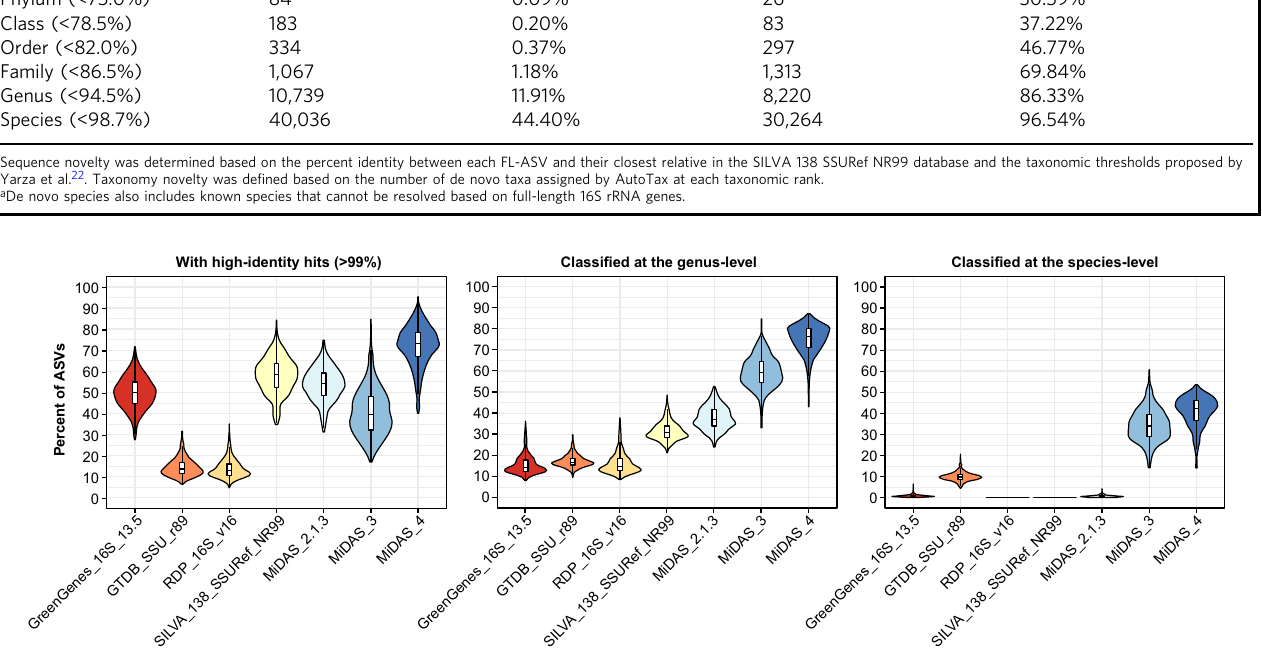
Fig. 3 Database evaluation based on amplicon data from the Global Water Microbiome Consortium project. Raw amplicon data from the Global Water Microbiome Consortium project 2 was processed to resolve ASVs of the 16S rRNA gene V4 region. The ASVs for each of the samples were fi ltered based on their relative abundance (only ASVs with ≥ 0.01% relative abundance were kept) before the analyses. The percentage of the microbial community represented by the remaining ASVs after the fi ltering was 88.35 ± 2.98% (mean ± SD) across samples. High-identity ( ≥ 99%) hits were determined by the stringent mapping of ASVs to each reference database. Classi fi cation of ASVs was done using the SINTAX classi fi er. The violin and box plots represent the distribution of percent of ASVs with high-identity hits or genus/species-level classi fi cations for each database across n = 1165 biologically independent samples. Box plots indicate median (middle line), 25th, 75th percentile (box) and the min and max values after removing outliers based on 1.5x interquartile range (whiskers). Outliers have been removed from the box plots to ease visualisation. Different colours are used to distinguish the different